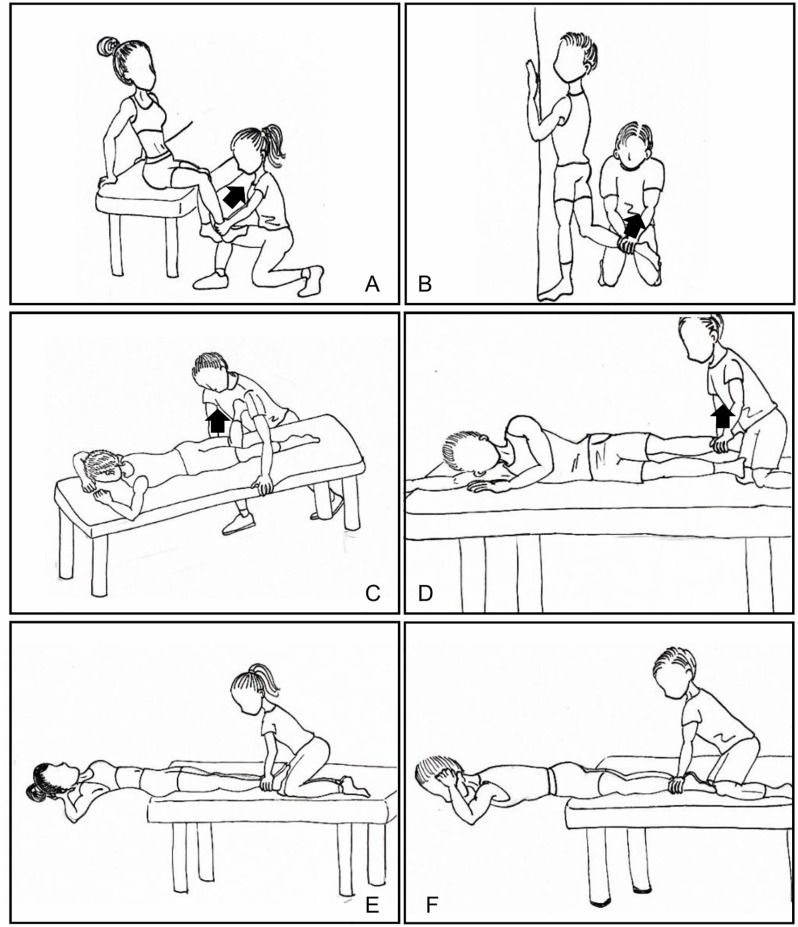
Maximum Voluntary Isometric Contraction (MVIC) tests for six targeting muscles.A: Rectus femoris (knee extension). B: Biceps femoris (knee flexion). C: Gluteus maximus (hip extension). D: Gluteus medius (hip abduction). E: Rectus abdominus (trunk flexion). F: Erector spinae (trunk extension).